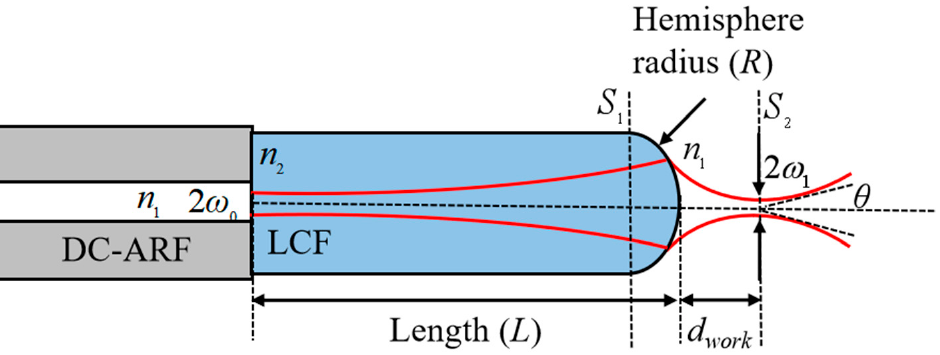
Figure 2. Geometric schematic of the lensed fi ber.